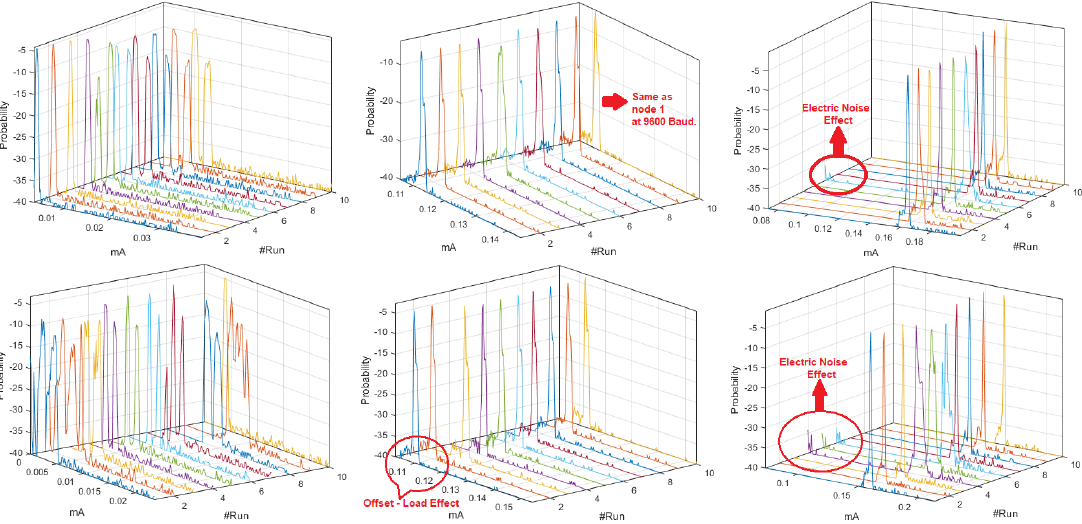
Figure 3. M-mode of pdf with distinctive characteristics for DigiMesh network. From left to right: Coordinator Node, Node 1, and Node 4. ( Top ) At 19,200 bauds; and ( Bottom ) at 57,600